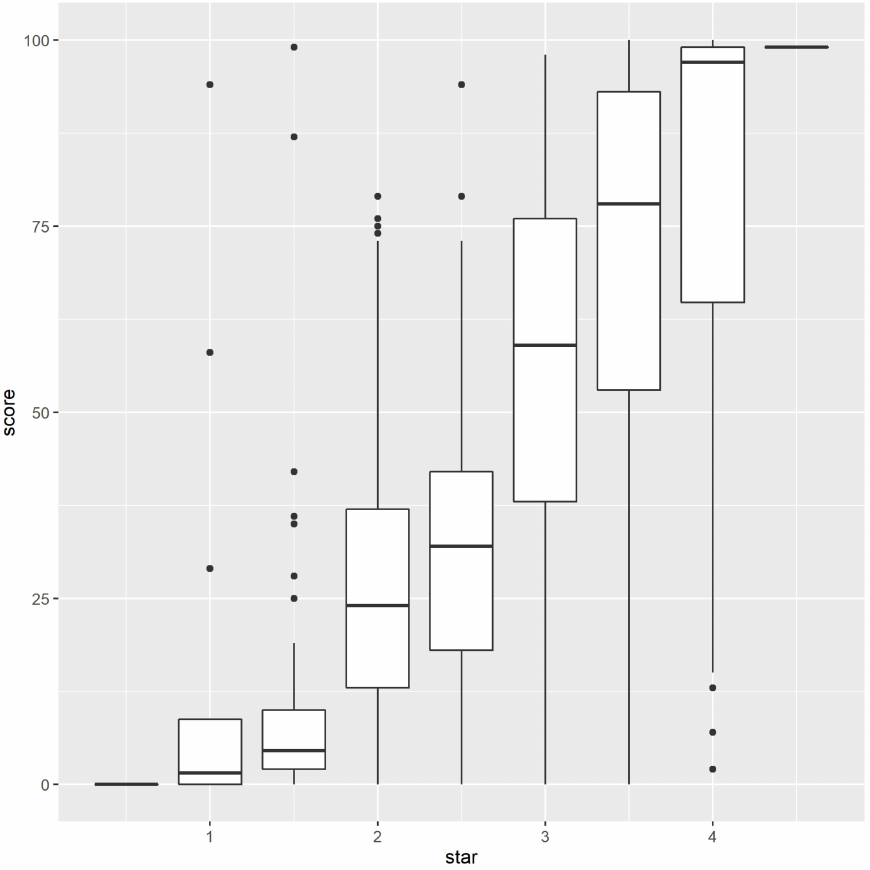
Figure 3. Boxplots visualizing the distribution of the new score as a function of the Health Star Rating (HSR) distribution in case of pizza category ( n =